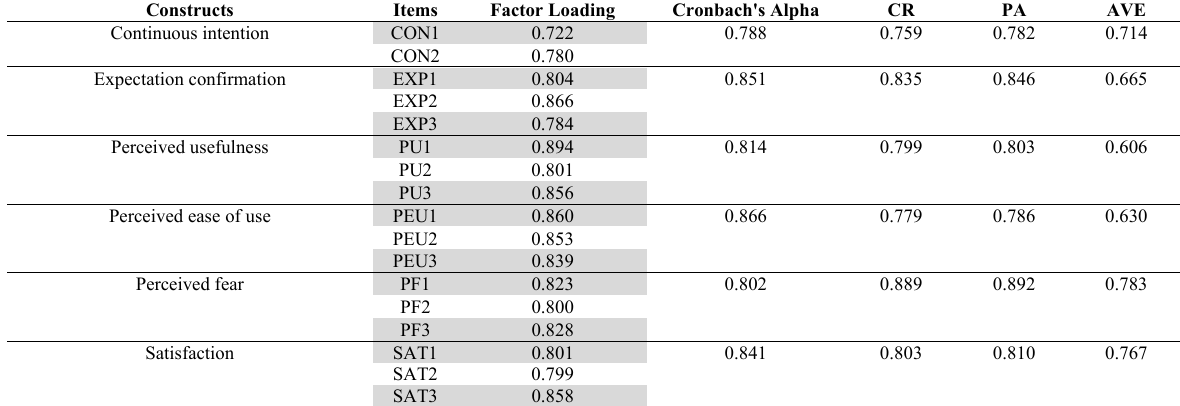
Convergent validity results which assure acceptable values (Factor loading, Cronbach’s Alpha, composite reliability, Dijks- tra-Henseler's rho ≥ 0.70 & AVE > 0.5).